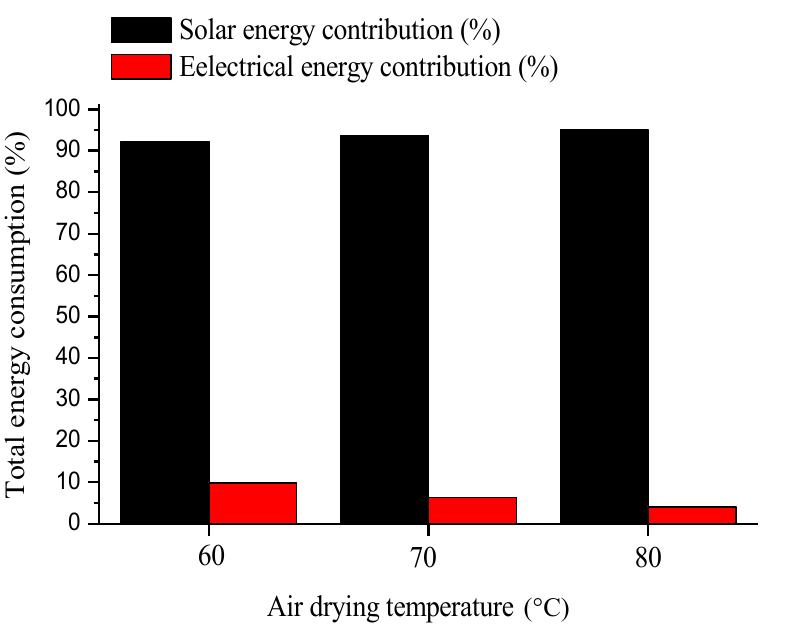
Figure 11. Contribution of solar and electrical energy during the drying process.